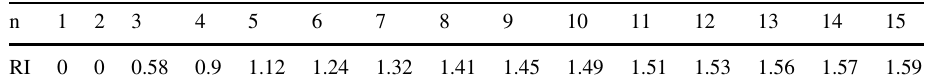
used for the study ( Source: Satty, 1990) n stands for the number of considering factors and RI is the random